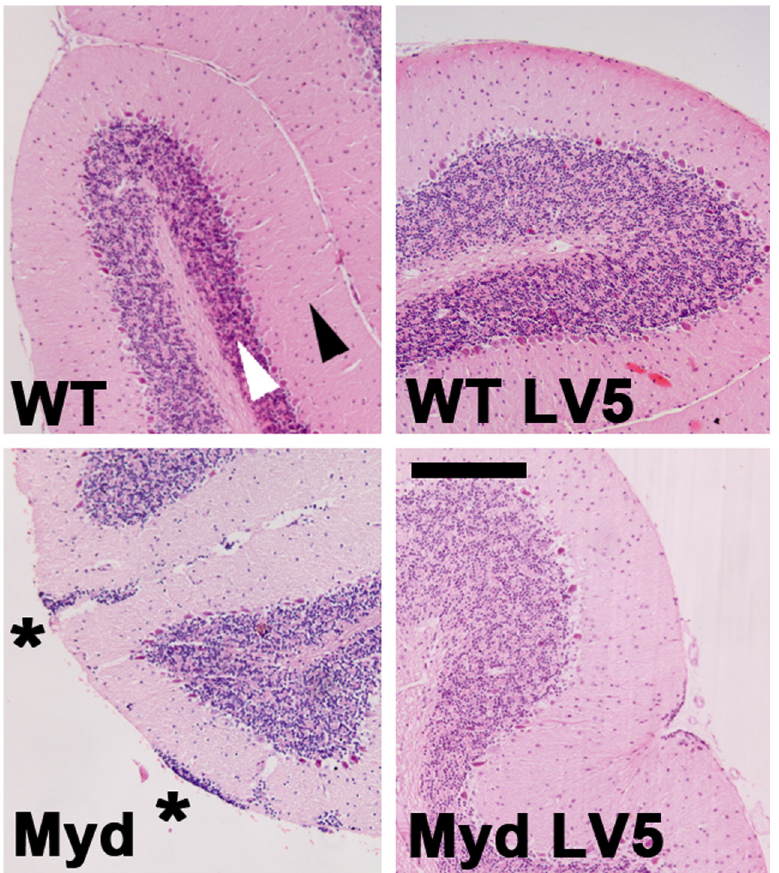
The molecular layer (black arrowhead) and granular cell layer (white arrowhead) are readily apparent in WT and WT-LV5 mice, with a single layer of large Purkinjie cells sandwiched between them. In LARGE myd mice, the granular cell layer is extensively disrupted with large aggregates of ectopic granule cells superficial to the molecular layer (asterisks). This disruption is corrected, and ectopic granule foci greatly reduced, in the LARGE myd -LV5 mice. Bar: 200 μ